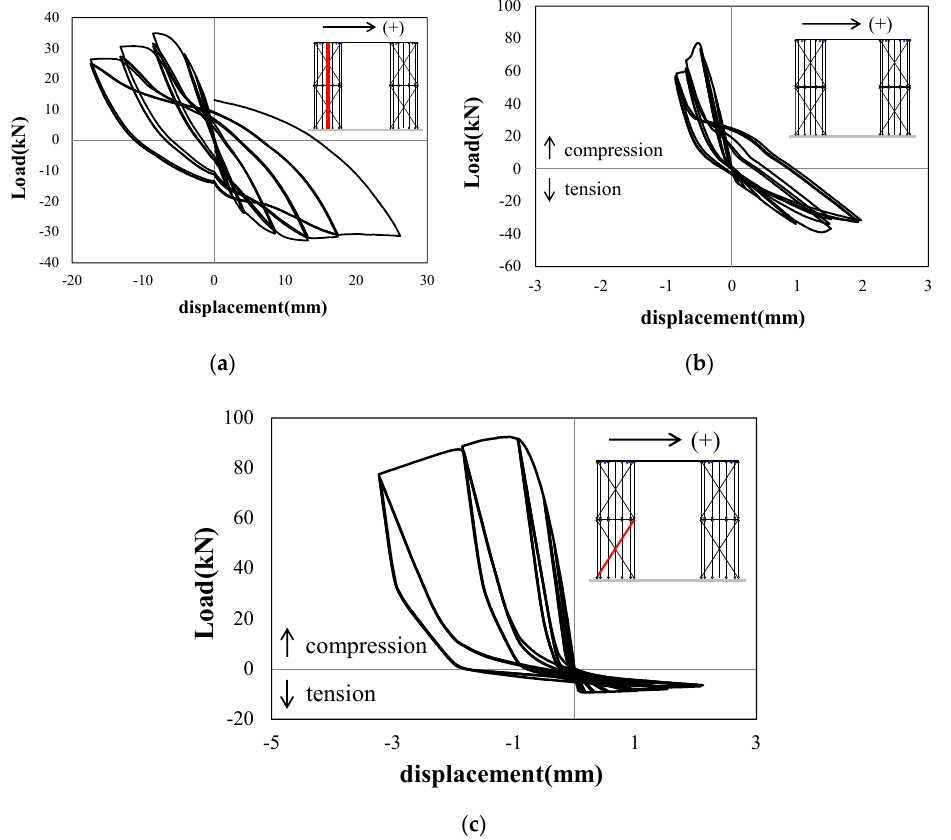
Figure 21. Estimated load–displacement responses of elements in Specimen FPB: ( a ) column; ( b ) longitudinal element; ( c ) diagonal element.